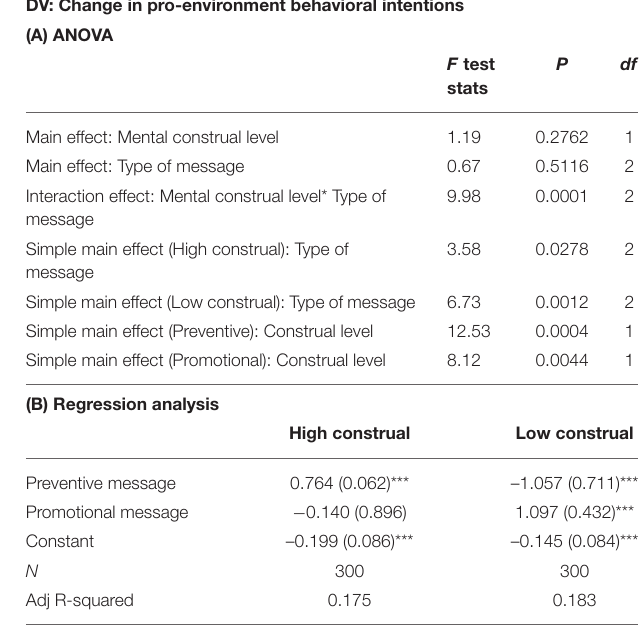
TABLE 3 | Testing for the effects of mental construal, technology messaging type, and their interaction on a response (Experiment 1: Feeling of assured). DV: Feeling of being assured